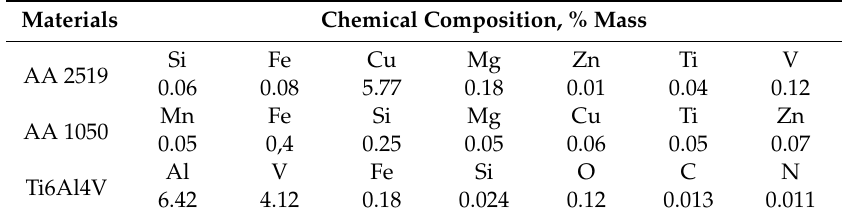
Table 1. Chemical composition of materials (wt.%) that make up AA2519–AA1050–Ti6Al4V layered material